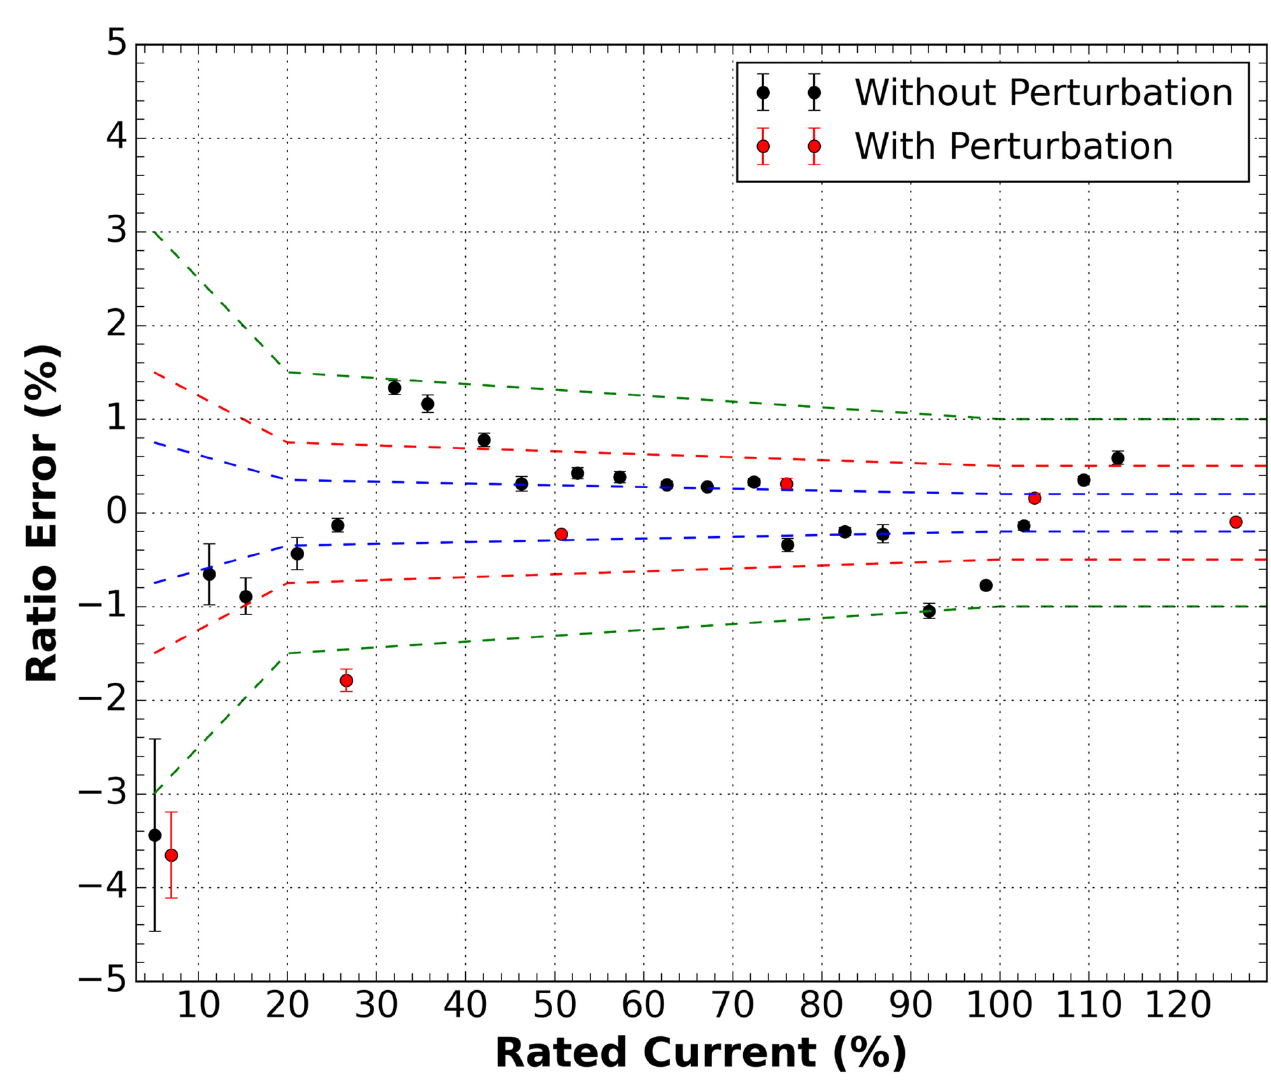
Figure 7. Ratio error measurements as a function of the rated current for the sensor inside the DWDM network. Two conditions were measured, with and without disturbance in the optical cable of the sensor. Green dashed lines are the 1.0 class limits, red dashed lines are the 0.5 class limits, and the blue dashed lines are the 0.2 class limits.